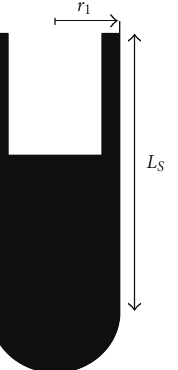
Figure 1: Viscometer tube and sinker.